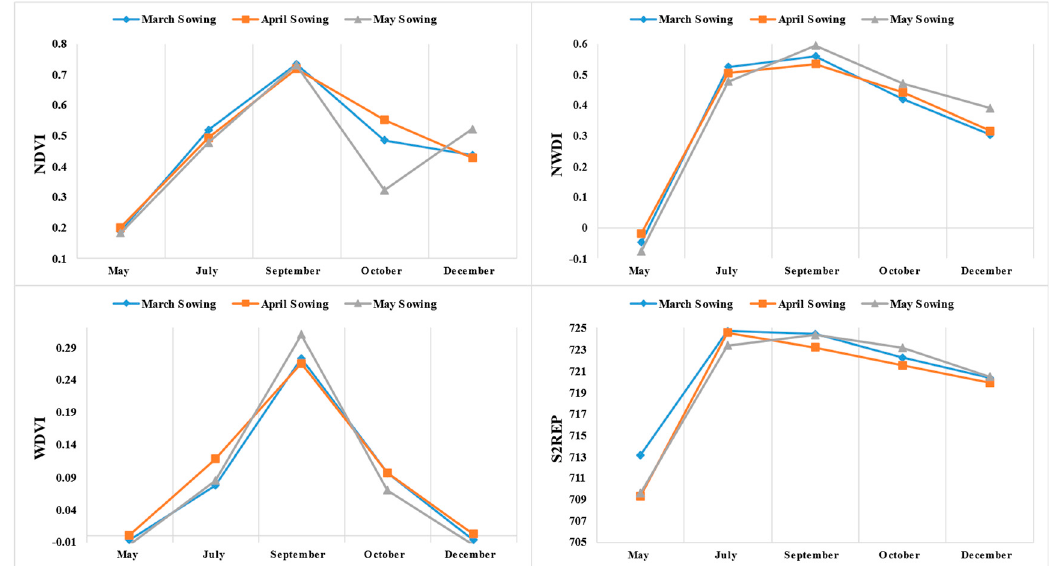
Figure 4. Temporal profile of Sentinel-1 parameters.